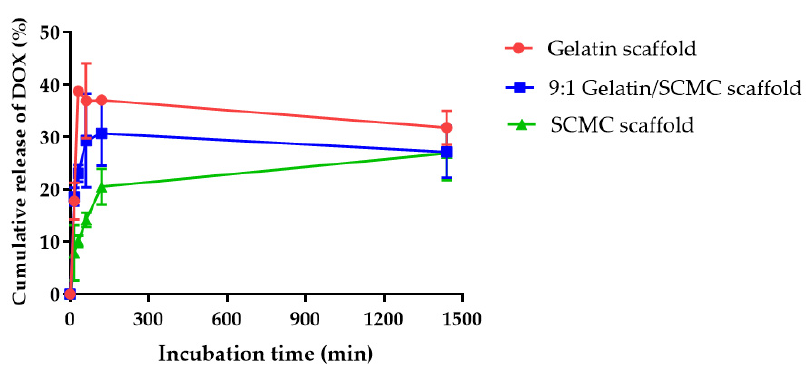
Figure 7. Release profiles of DOX from gelatin, 9:1 gelatin/SCMC, and SCMC scaffolds. Data are expressed as mean ± S.D.